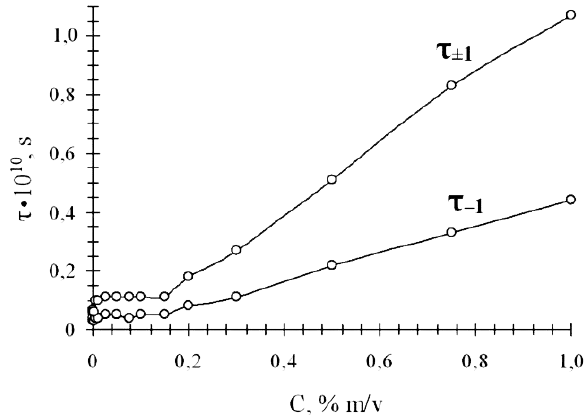
Fig. 6. Rotational correlation time (τ) of probe 5 vs concentration (C) of BC solutions